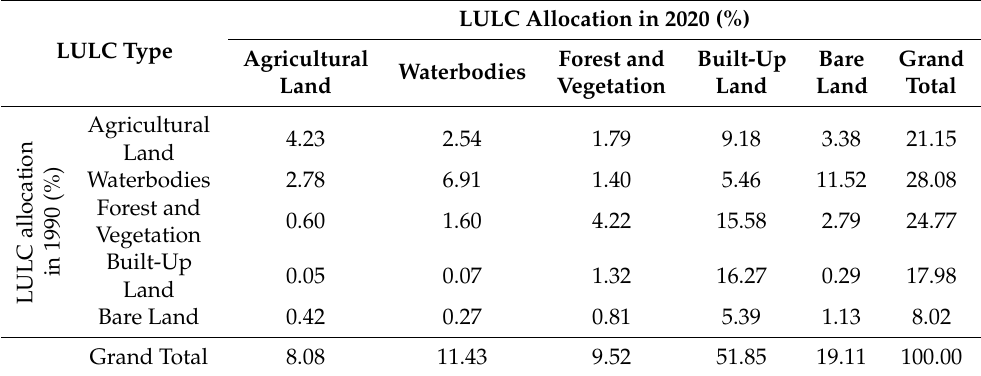
Table 6. LULC transition matrix in Dhaka during the period